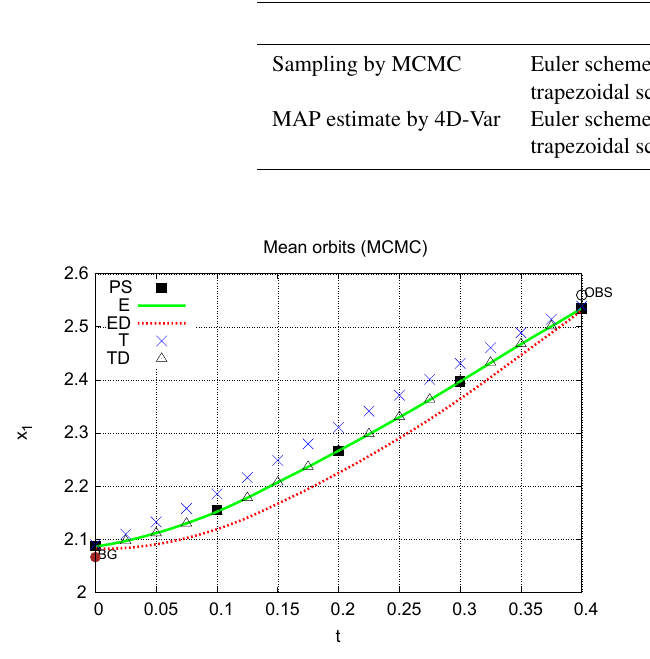
Table 1. Applicable OM schemes.